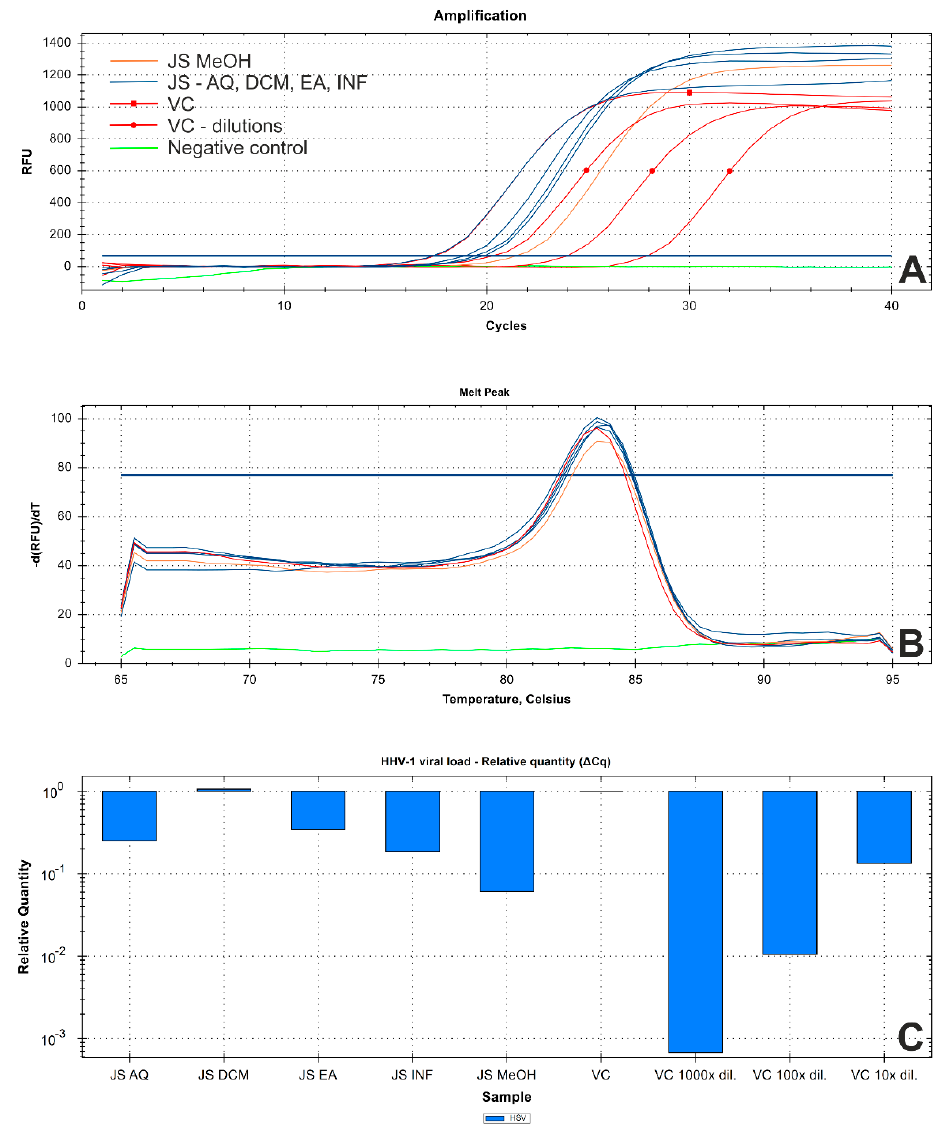
Figure 6. Results of real − time PCR analysis of the HHV − 1 viral load in tested samples (( A )—ampli-